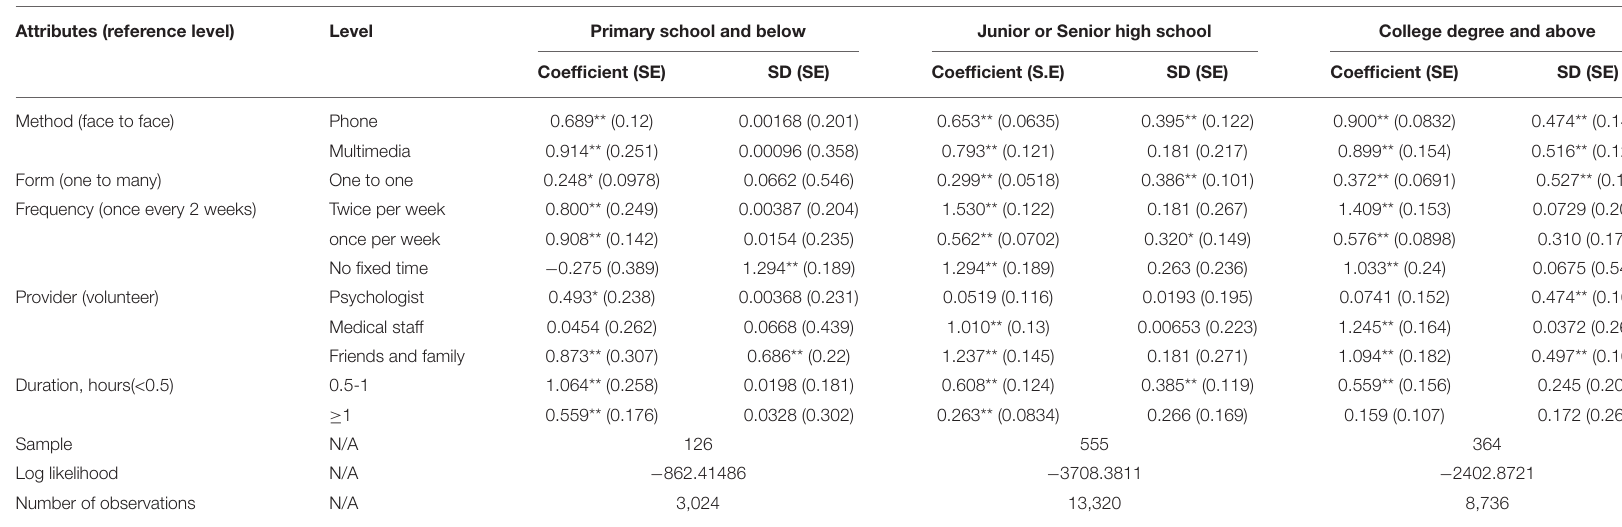
TABLE 4 | The results of subgroup